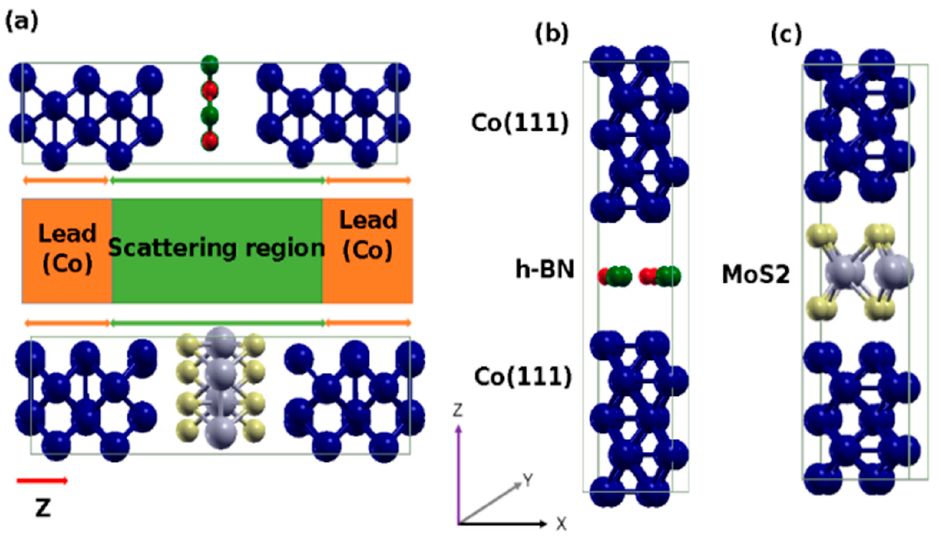
Figure 1. The schematic of the multilayer heterostructures with leads and scattering region, where vector Z denotes the axis of spin quantization and the spin transport direction ( a ). The unit cell showing the optimized local structure in the Co(111)/hBN/Co(111) stack, where B and N atoms are shown in green and red ( b ), and the optimized local structure in the Co(111)/MoS 2 /Co(111) stack, where Mo and S atoms are shown in grey and yellow ( c ).